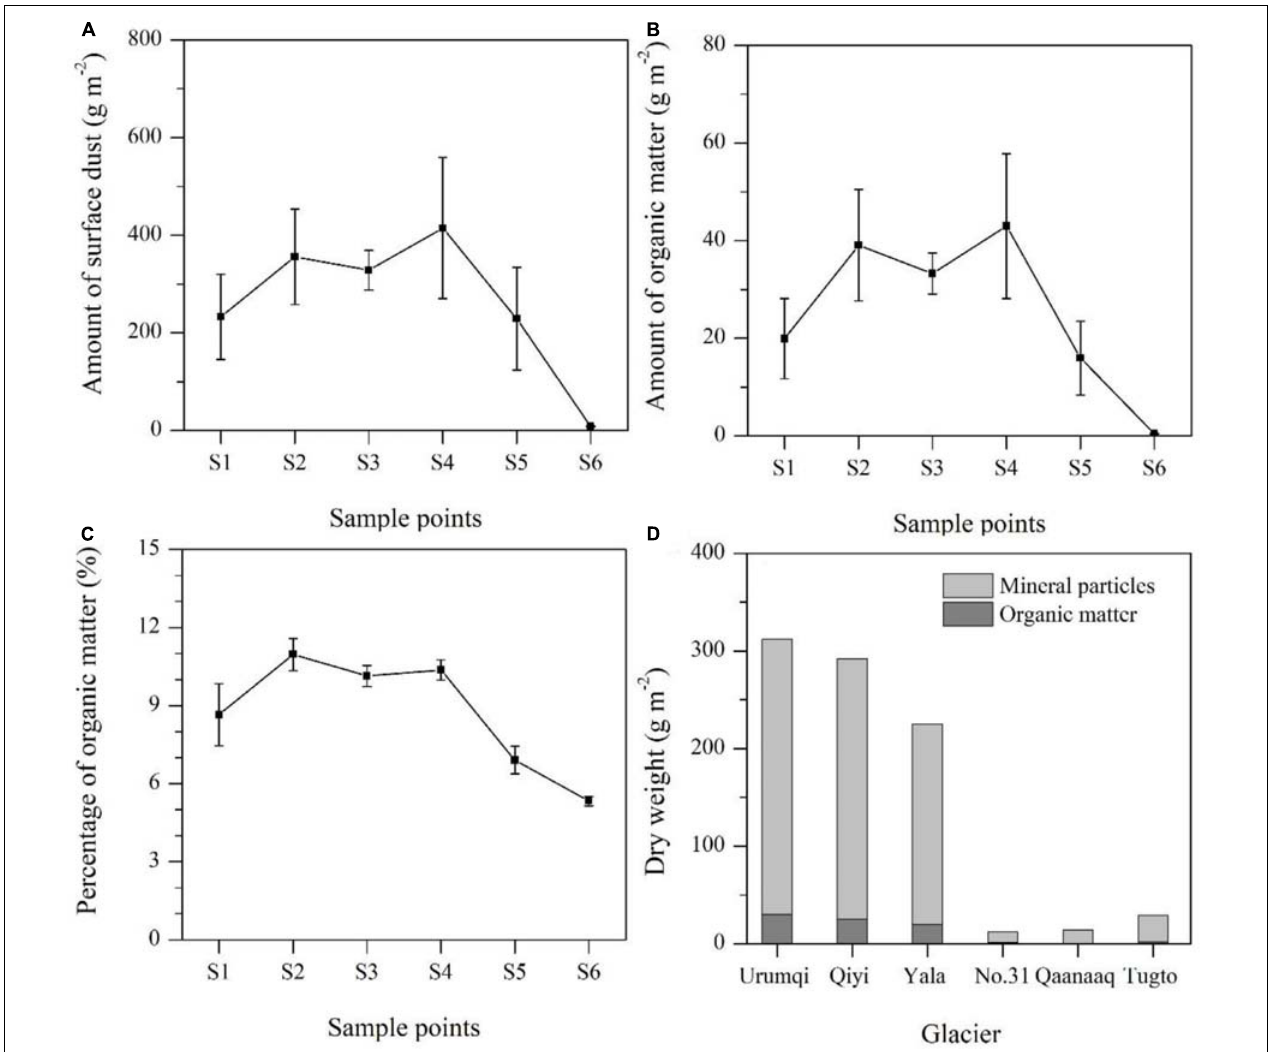
FIGURE 6 | Variations in amount of surface dust (A) and organic matter (B) , and percentage organic matter (C) on the Urumqi Glacier No. 1. Error bars indicates standard deviation. (D) Is the comparison of amounts of surface dust and their components among various glaciers around the world. Snow line located between site S5 and